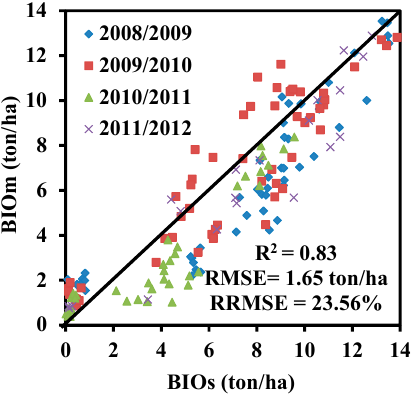
Figure 3. Comparison of data assimilation biomass ( BIOs ) and field measurement biomass ( BIOm ) values in winter wheat across the four experiments.